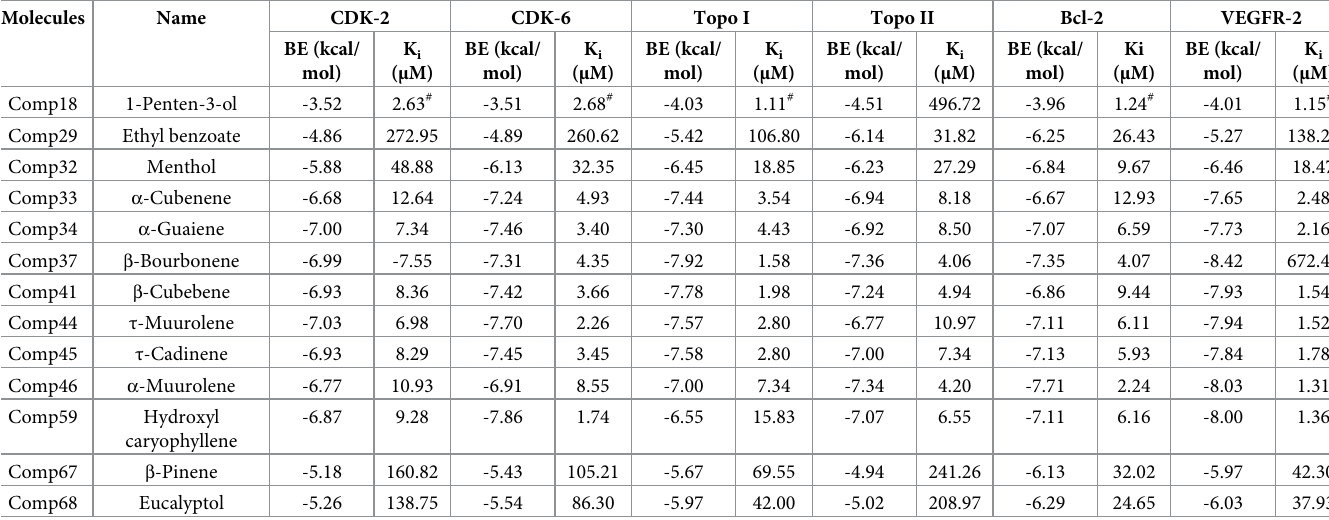
Table 2. Binding energies and inhibition constants of selected compounds derived from Ficus carica docked against target protein receptors.